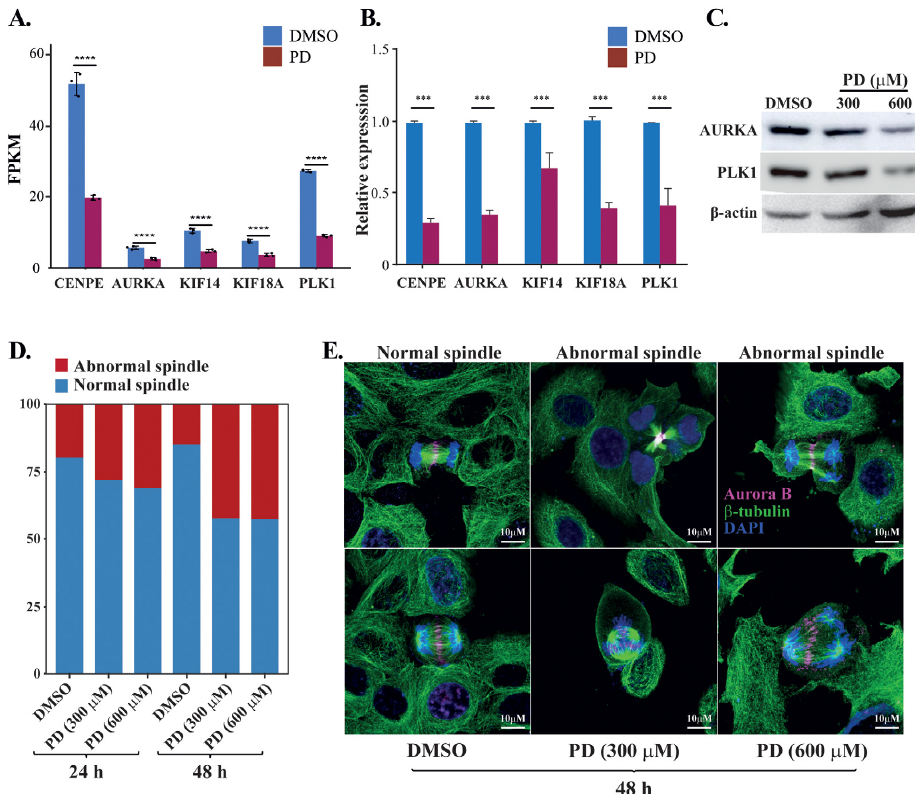
Figure 6. Analyses of PD ‐ repressed genes regulating spindle midzone formation. ( A ) FPKM changes of the five genes CENPE, AURKA, KIF14, KIF18A and PLK1 regulating the spindle midzone in the RNA ‐ seq dataset of PD ‐ treated HepG2 cells versus DMSO ‐ treated cells. FPKM (fragments per kilo base of transcript per million mapped fragments) is a gene expression unit to normalize counts for paired ‐ end RNA ‐ seq data in which two (left and right) reads are sequenced from the same DNA fragment. ( B ) RT ‐ qPCR analyses of the five genes in the PD ‐ and DMSO ‐ treated HepG2 cells. In ( A , B ), *** denotes p < 0.001 and **** denotes p < 0.0001. ( C ) Western blot analyses of the AURKA, PLK1 and β‐ actin expression in the HepG2 cells treated by DMSO, 300 and 600 μ M of PD. The three antibodies are against AURKA (cat# D3E4Q, Cell Signaling), PLK1 (cat# sc ‐ 17783, Santa Cruz), β‐ actin (cat# A5441, Sigma ‐ Aldrich). ( D , E ) Analyses of spindle formation during the mitosis of HepG2 cells treated by DMSO, 300 and 600 μ M of PD. In D, over 130 mitotic cells were evaluated for each treatment at 24 and 48 h time points, and the percentages of cells with abnormal and normal spindles were presented. In E, representative images of normal spindles in DMSO ‐ treated HepG2 cells and the abnormal spindles in 300 and 600 μ M PD ‐ treated cells for 48 h. AURKB was stained in magenta showing the positions of spindle midzone, α ‐ tubulin was stained in green showing the microtubules in spindles and DAPI was used to display the nuclei. The experiments have been repeated with the results of a similar tendency and representative data are shown.